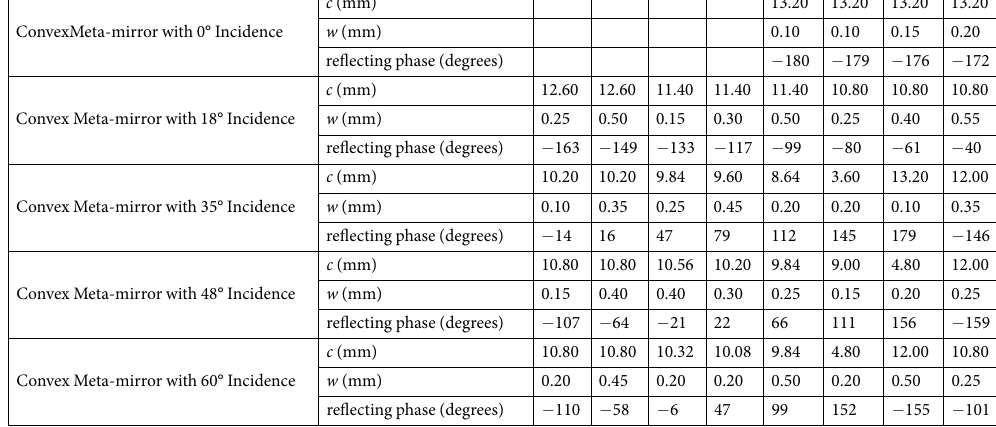
Table 2. The dimensions and the corresponding reflecting phases of the ring patches for the convex meta- mirror with the excitation at the focal point.